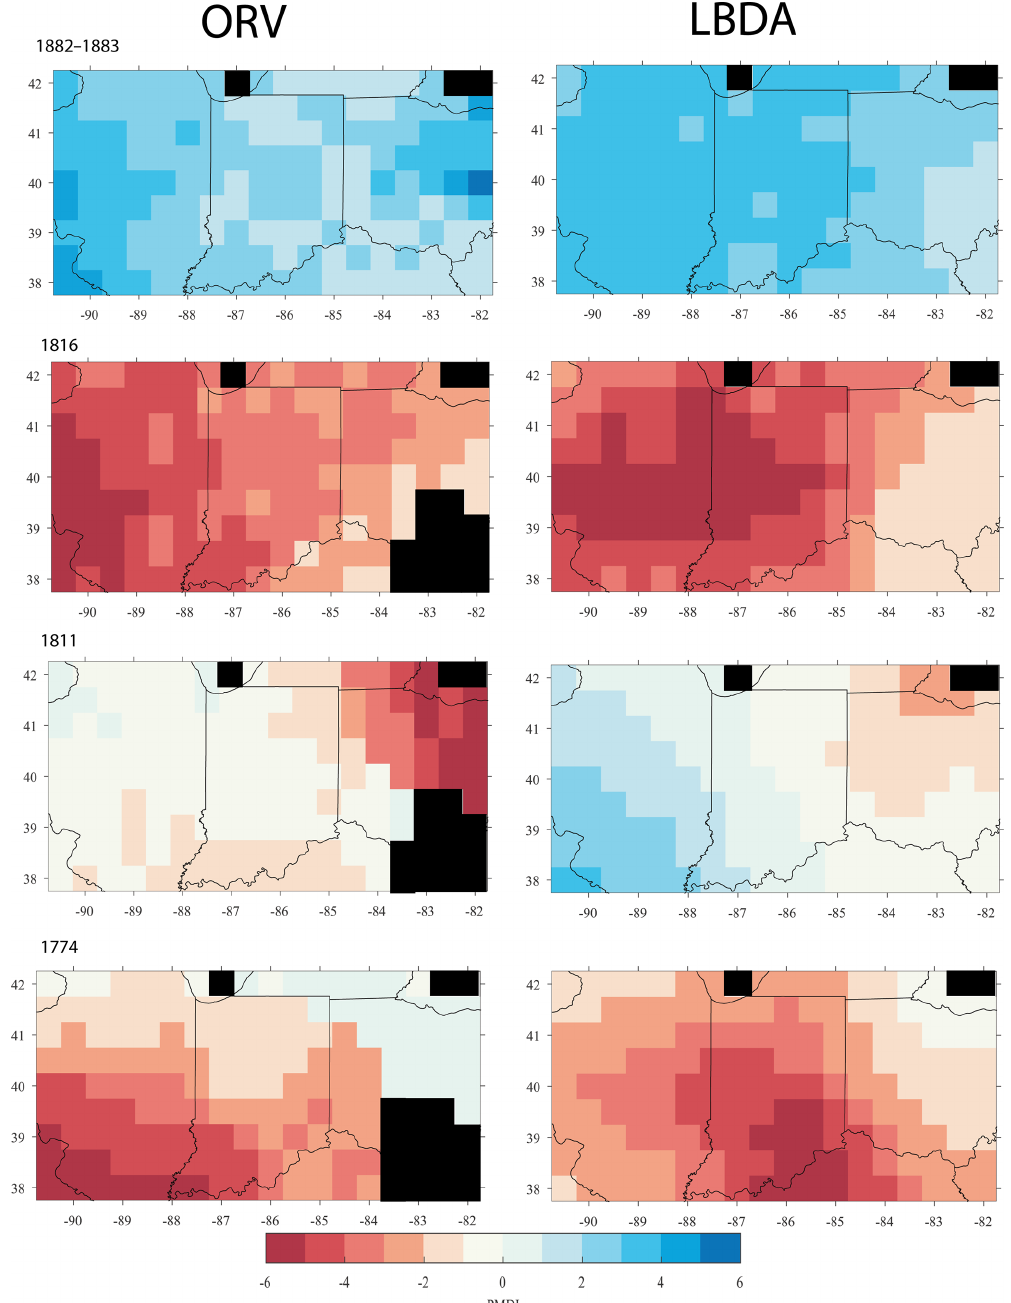
Figure 3. Spatial comparison of the ORV (left column) and the LBDA (right column) of reconstructed PMDI during years that experienced hydroclimatic extremes. Red cells represent below-average PMDI and blue cells represent above-average PMDI. Black cells represent no data, either due to being over water or from not having at least five chronologies to create a